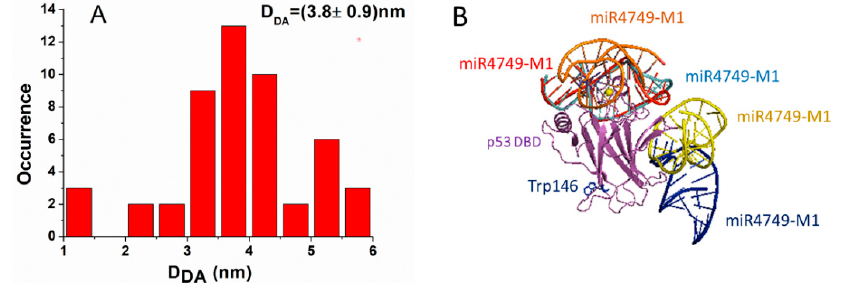
Figure 5. ( A ) Histogram of the D DA distance in the 50 models for the DBD-miR4749 complex. The distance was measured between the 5 ′ end of miR4749 to which the Atto390 dye is bound and the center of the aromatic rings of the lateral chain of Trp146 of DBD. ( B ) Collective representation of the five best models for DBD-miR4749 complex. DBD is colored in magenta, while miR4749: Model 1 (red), Model 2 (blue), Model 3 (orange), Model 4 (yellow) and Model 5 (azur).